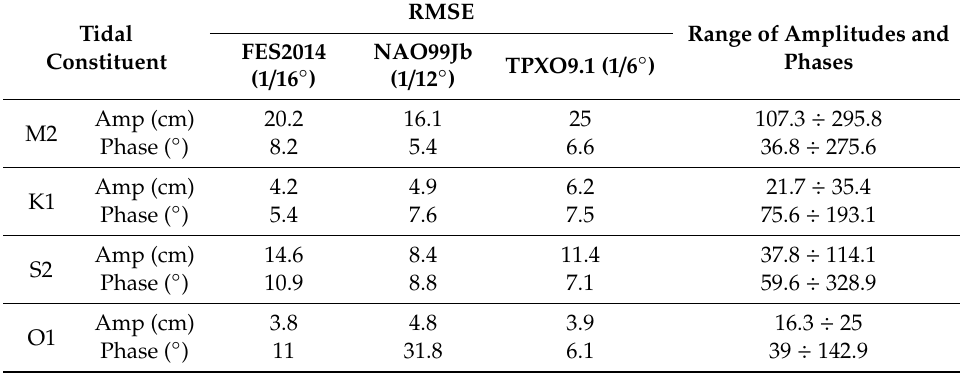
Table A1. Validation of amplitude and phase obtained from three tidal models against observation